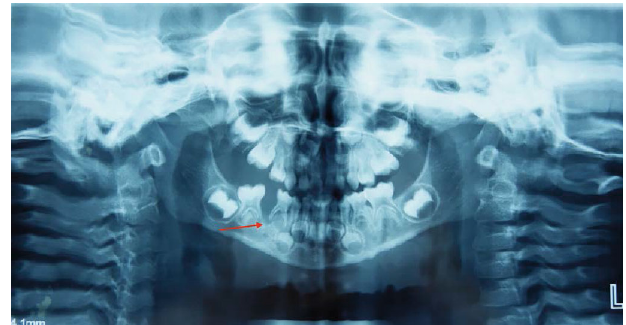
Figure 1: Orthopantomograph showing the presence of an ill-de fi ned, mixed radiolucent-radiopaque lesion involving the #84 to #85 region. Bone and roots resorption can be observed (red